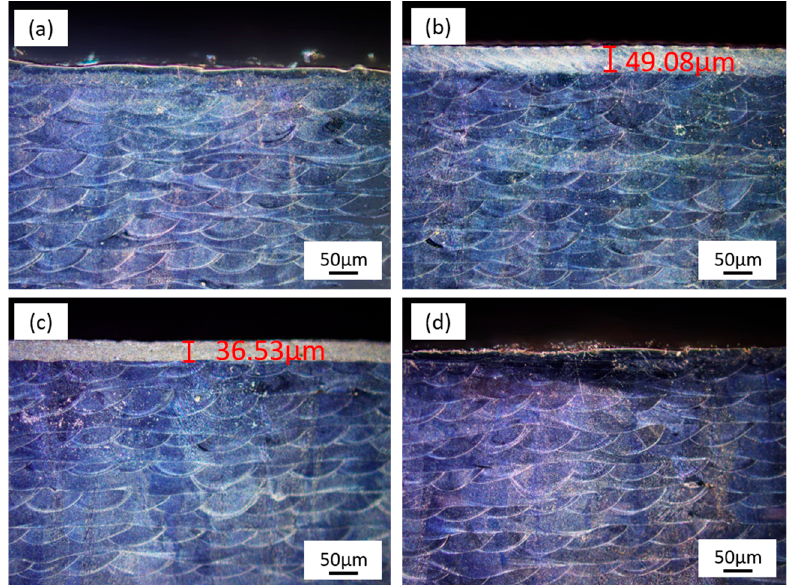
Figure 7. Cross-sectional micrographs of the ( a ) original, ( b ) CW, ( c ) NS, and ( d ) FS laser-polished 316L stainless steel surfaces.